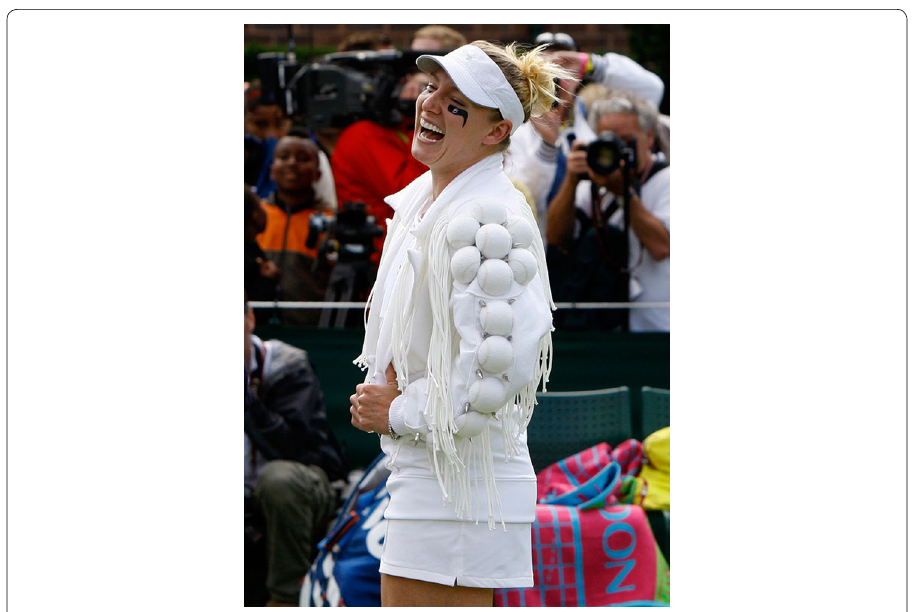
Fig. 1 Bethanie Mattek-Sands in an outfit by Alex Noble, Wimbledon 2011. Photograph: The Associated Press/Mark Baker (reproduced in Lynch